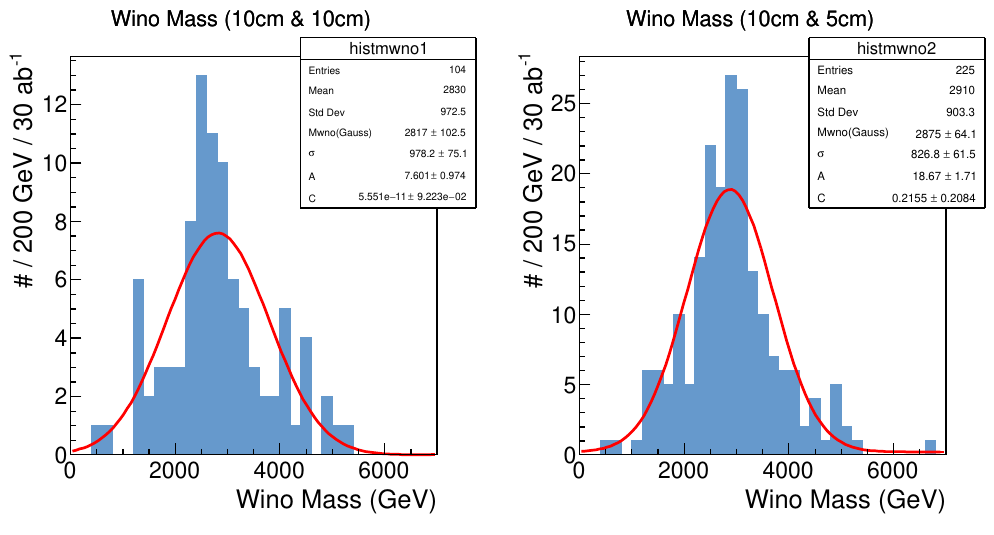
Figure 4 . Distribution of the reconstructed Wino mass for Sample Point 3, taking L (min) (left) and 5 cm (right) in a single experiment with the integrated luminosity of L = 30 ab (cid:0) 1 .